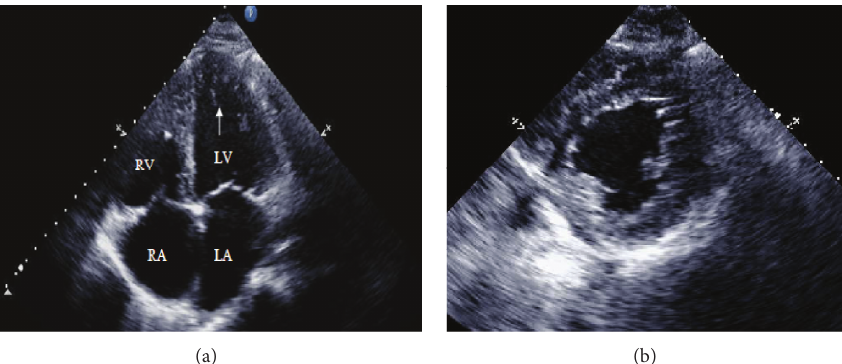
Figure 1: Echocardiogram of the heart. (a) Apical four-chamber view of the heart with marked trabeculations of the apex (white arrow). (b) Parasternal short axis view at the level of the papillary muscles with prominent LV inferolateral trabeculations. RA: right atrium, LA: left atrium, RV: right ventricle, and LV: left ventricle.